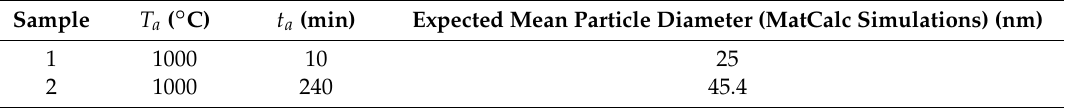
Table 2. Heat treatments of the sample